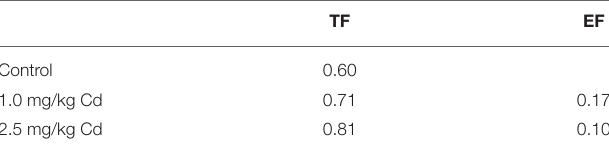
TABLE 1 | Enrichment Factor (EF) and Translocation Factor (TF) in snapdragons under different cadmium